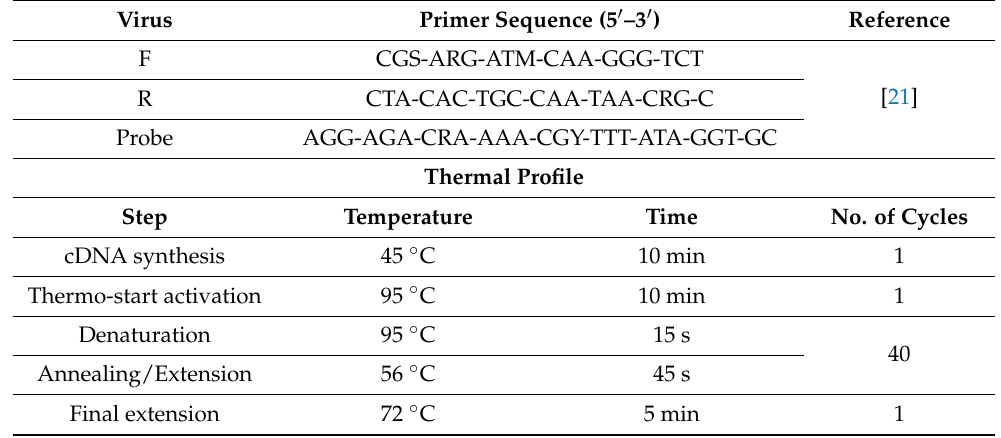
Table 2. Oligonucleotide primers and thermal profile of virulent Newcastle disease virus RT-qPCR.